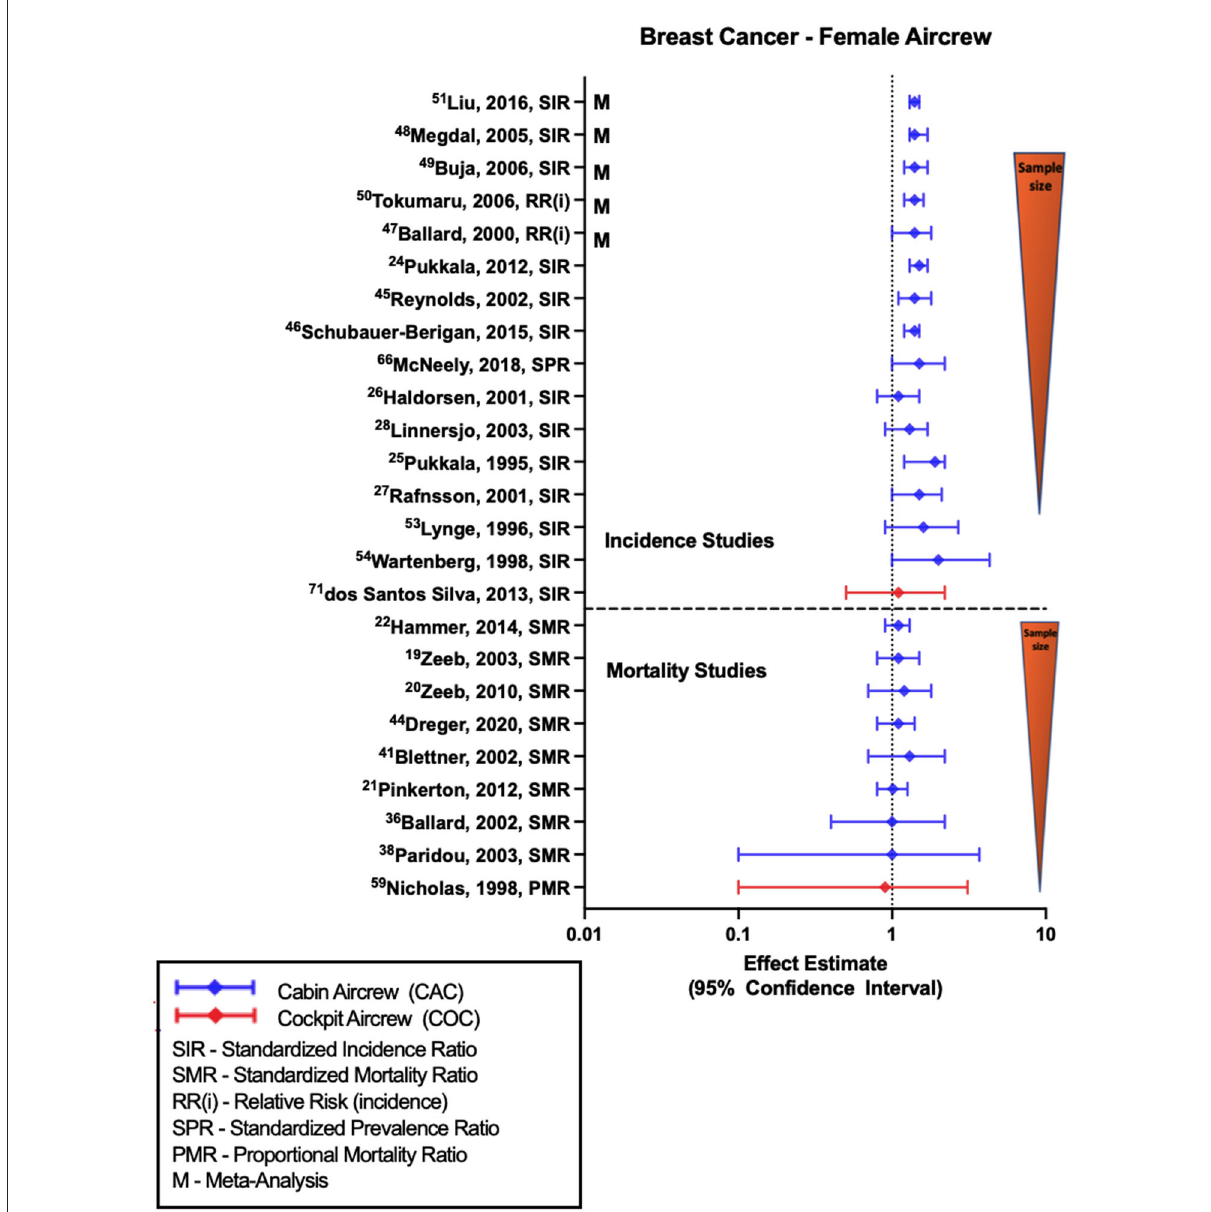
FIGURE1 Forest plot for studies evaluating breast cancer incidence or mortality ratios among female aircrew in association to CIR